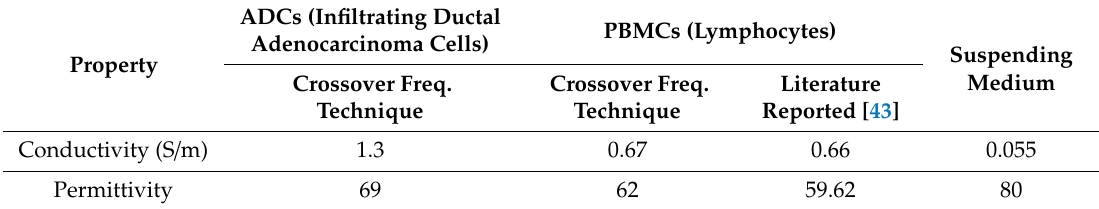
Table 2. Dielectric properties, i.e., conductivity and permittivity obtained from our novel electrokinetic technique based on cell response obtained at crossover frequency for ADCs and healthy PBMCs using an osmotic concentration suspending medium maintained at osmotic conductivity and permittivity. Literature reported values has been compared with our novel technique for PBMCs only as a measure of validation [43]. ADCs (Infiltrating Ductal PBMCs (Lymphocytes) Adenocarcinoma Cells) Suspending Property MediumCrossover Freq. Crossover Freq. Technique